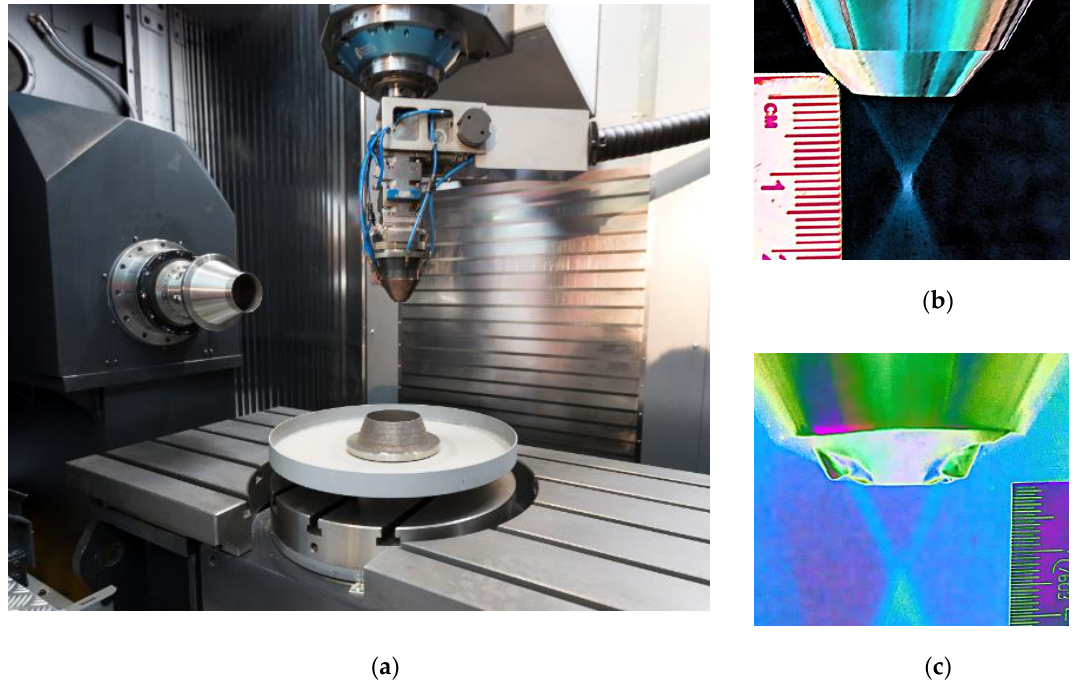
Figure 1. ( a ) IBARMIA ZVH45 / 1600 Add + Process hybrid machine; ( b ) continuous coaxial nozzle with a 0.5 mm slit; ( c ) 4-stream discrete coaxial nozzle.